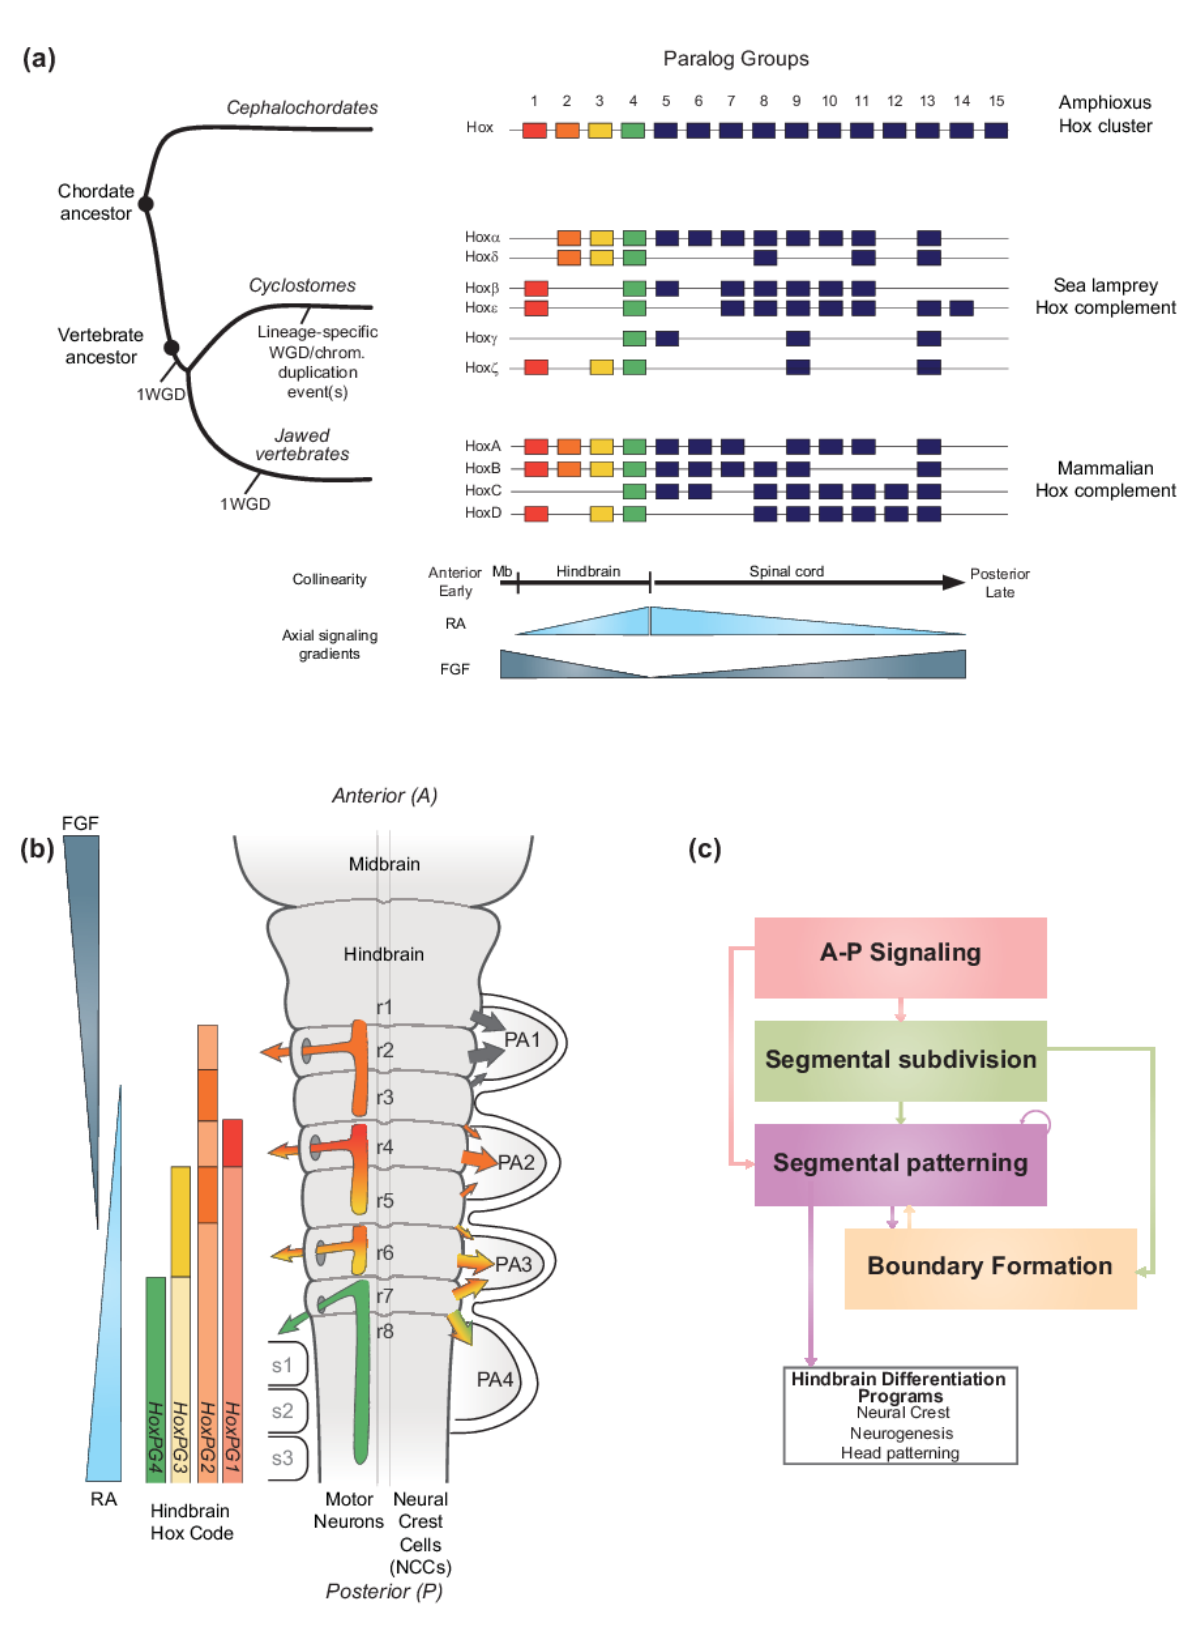
Figure 1. Hox genes and vertebrate hindbrain segmentation. ( a ) Schematic representation of the evolution of Hox clusters in different chordate models-amphioxus, sea lamprey and mouse, illustrating the different ways gene families can evolve following major genome rearrangements. Amphioxus displays one Hox cluster, suggesting that the chordate ancestor likely possessed one Hox cluster. In vertebrates, multiple whole genome duplication (WGD) and/or chromosomal scale